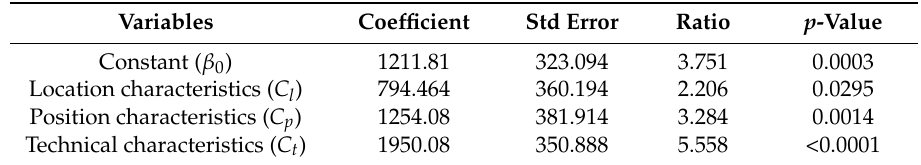
Table 6. The value function of residents’ market segment, robust standard errors with respect to heteroskedasticity, HC1